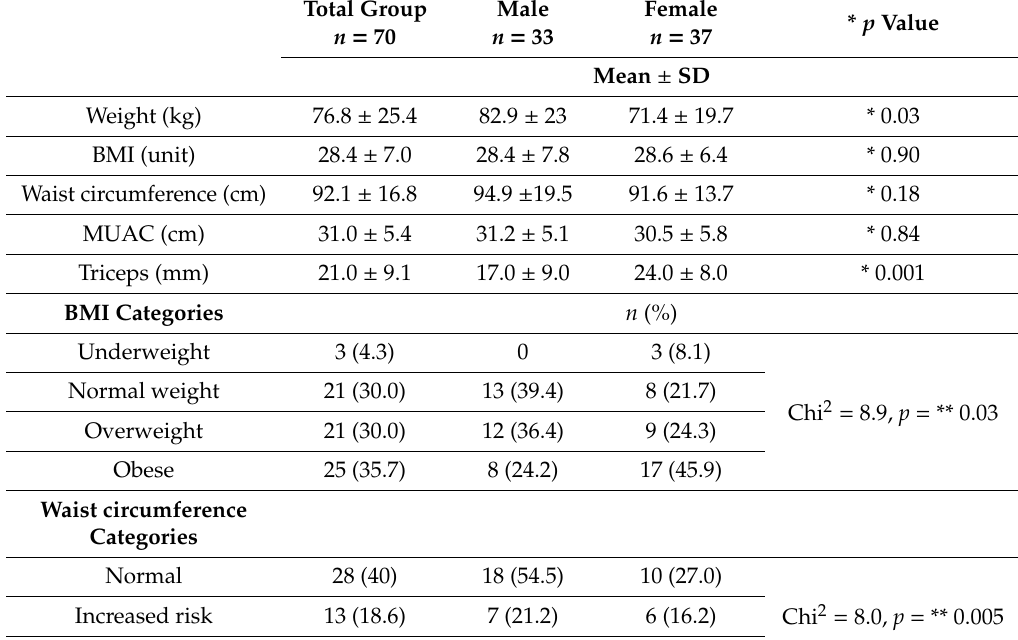
Table 3. Anthropometry for total group and